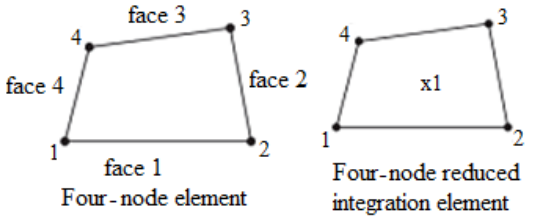
Figure 9 : Stress deformation scheme for steel (current study).